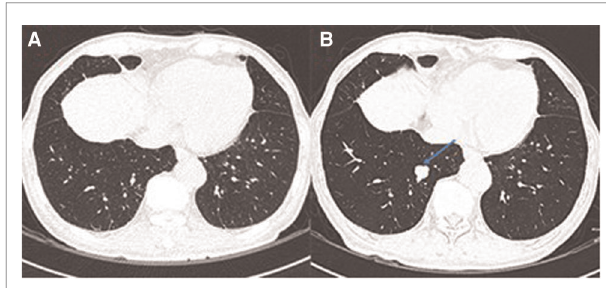
FIGURE 3 | Newly-occurred lung metastases after metastasectomy. ( A ) No lung metastases before metastasectomy. ( B ) The metastatic lesion in the right lower lobe (arrow) 10 months after